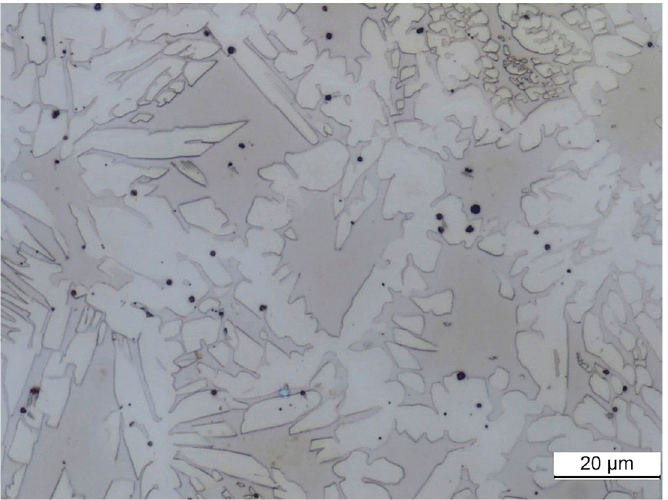
Figure 8. Reheated layer microstructure of Wall 1.